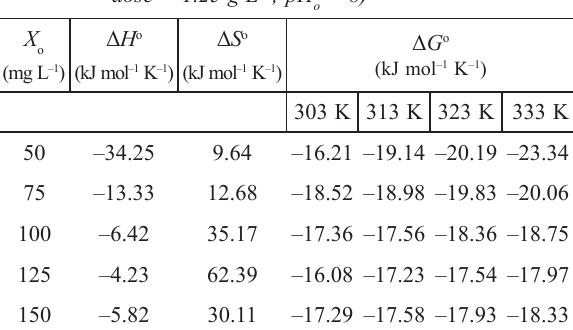
Table 4 – Thermodynamic parameters for 2-CP abatement by RSAC